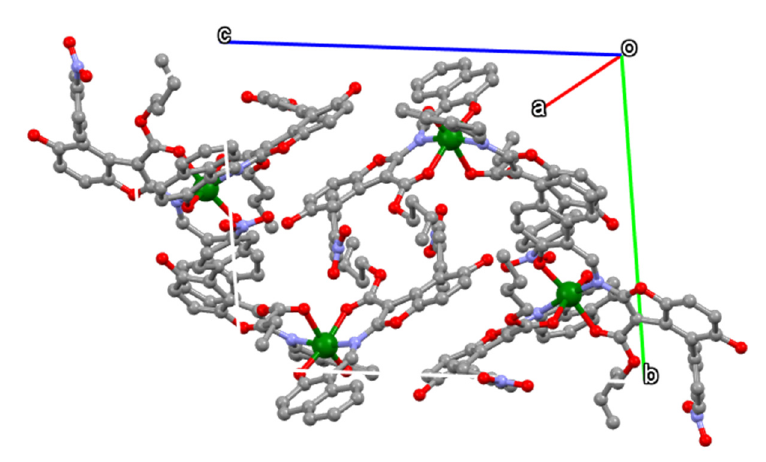
Figure 5. Crystal packing of L 2 Zn complex along a axis direction. Table 2. Data collection and refinement statistics for L and L 2 –Zn complex.